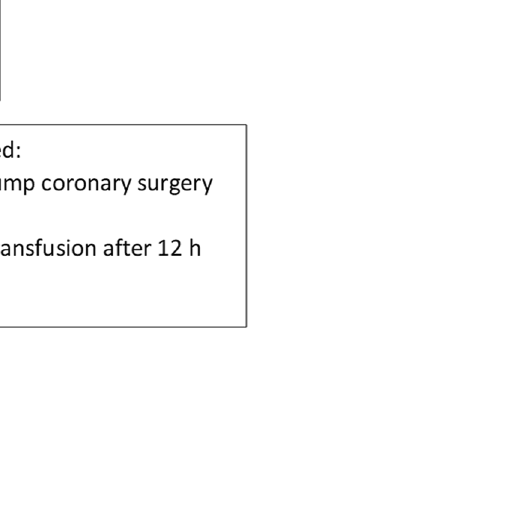
Table 3. Patients who received RBC transfusion during the first 12 h perioperatively had substantially higher rates of strokes, postoperative pneumonia, de novo dialysis, and mortality during the index hospitalization as well as longer intensive care unit and hospital stay. In the PSM cohort, there were more adverse events in the RBC transfusion group and this was mainly driven by higher postoperative pneumonia and stroke rates.